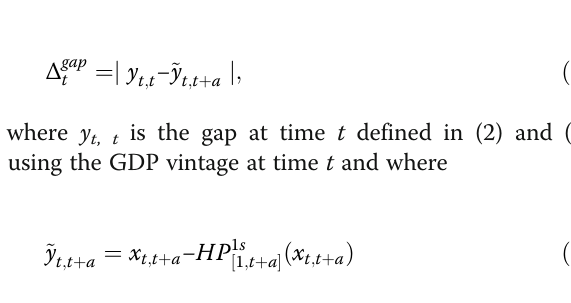
Fig. 6 Absolute error distribution in gap estimates resulting purely from the end-point problem. Quarterly gap differences in percentage